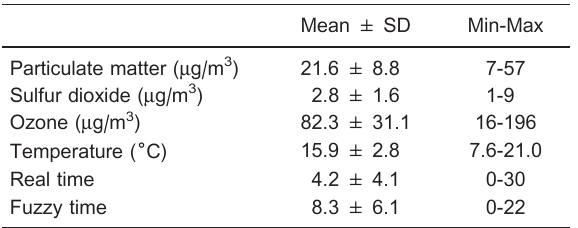
Table 1. Mean ± SD values, minimum, and maximum (Min- Max) of the study variables, Sa˜ o Jose´ dos Campos, SP, Brazil, 2009.